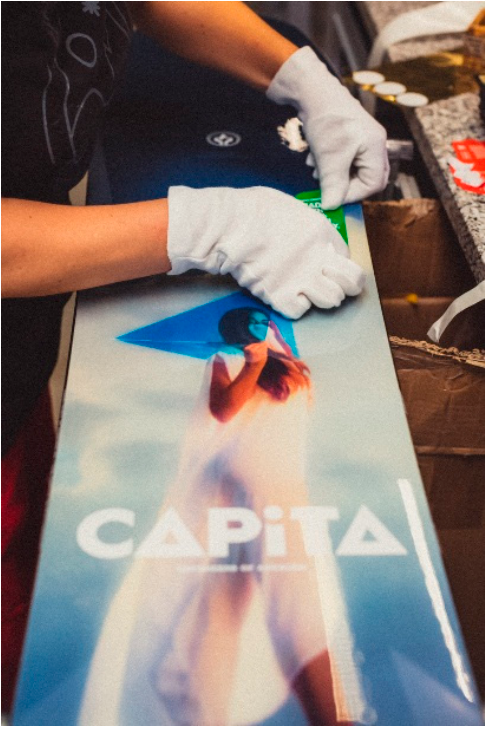
Figure 10. Bcomp Manufacturer’s longboards made from natural fiber.